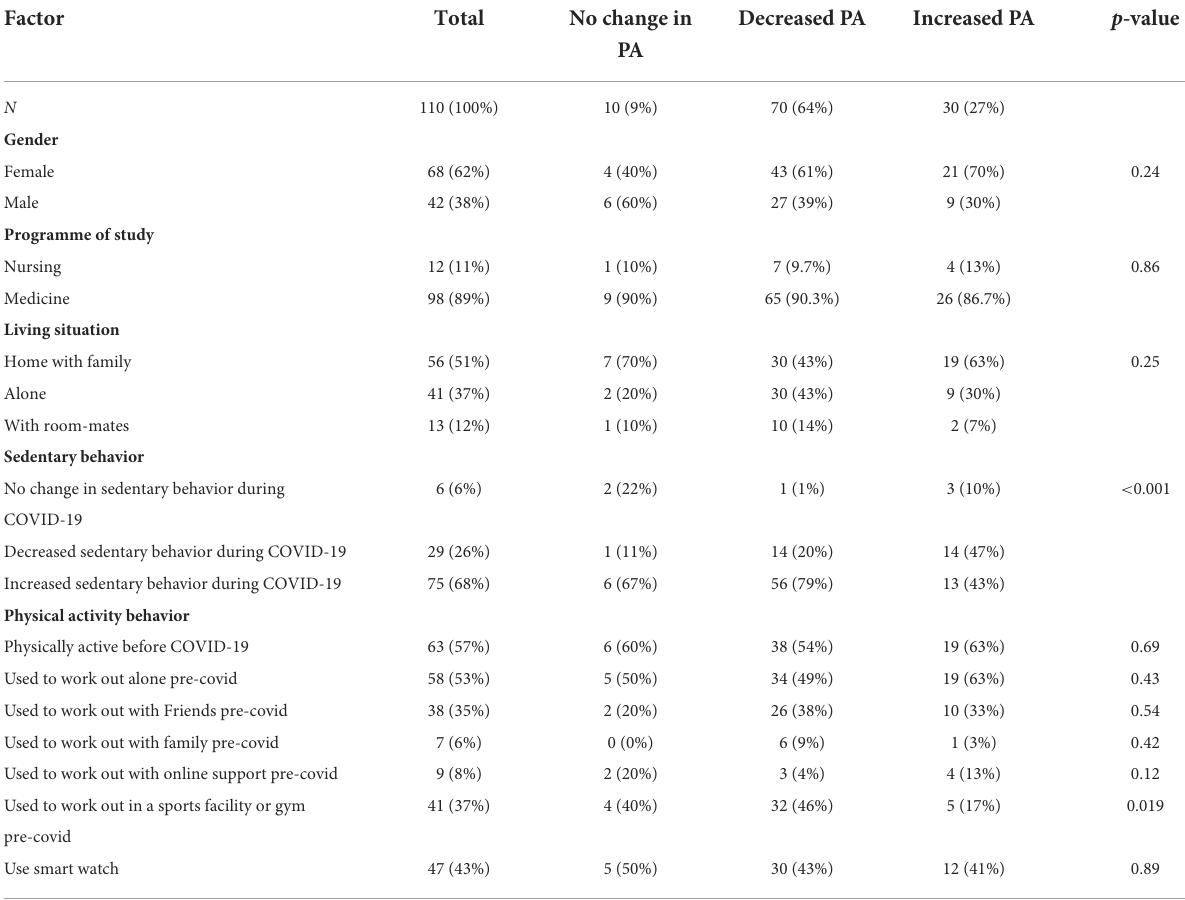
TABLE 2 Participant characteristics according to change in physical activity (PA) levels during COVID-19 social distancing measures # . Factor Total No change in